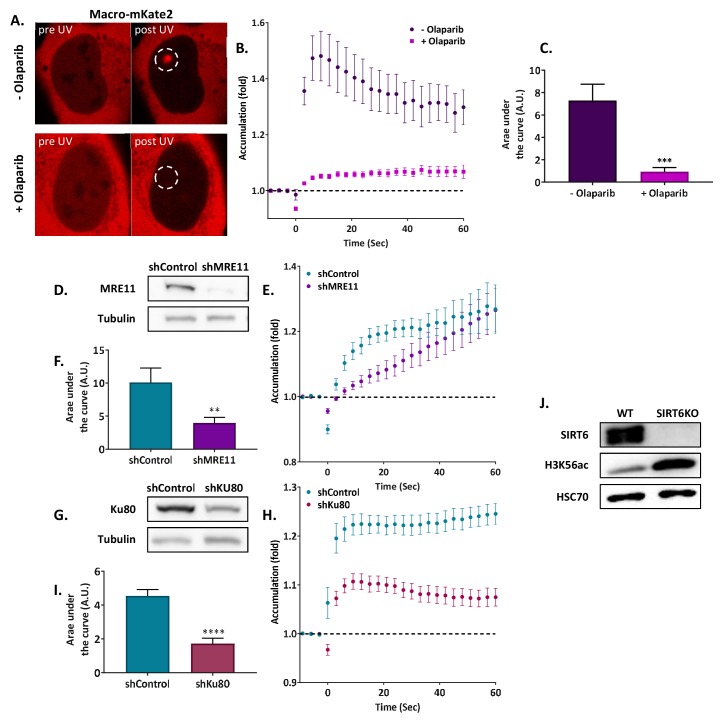
SIRT6 arrivesatsites of damage independently of other repair factors.(A, B) Effect of LID on Macro-domain mKate2 in U2OS +/- Olaparib. (n[+Ola]=10, n[-Ola]=10). (C) Average AUC of Macro-mKat2 in U2OS +/- Olaparib for three replicated experiments (error bars are SEM) (n[+Ola]=25, n[–Ola]=25, p<0.0005). (D) Blot of shControl and shMRE11 Hela cells. (E) Effect of LID on NBS1-Cherry in shControl (n = 10) and shMRE11 Hela cells (n = 10). (F) Average AUC for three replicate experiments +/- SEM (n[shControl]=29, n[shMRE11]=30, p<0.005)). (G) Protein blot of shControl and shKu80 Hela cells. (H) Effect of LID on Ku70-GFP accumulation in shControl (n = 10) and shKu80 Hela cells (n = 10). (I) Average AUC for three replicate experiments. Error bars are SEM (n[shControl]=33, n[shKu80]=31, p<0.0001). (J) Blot of WT and SIRT6KO cells.